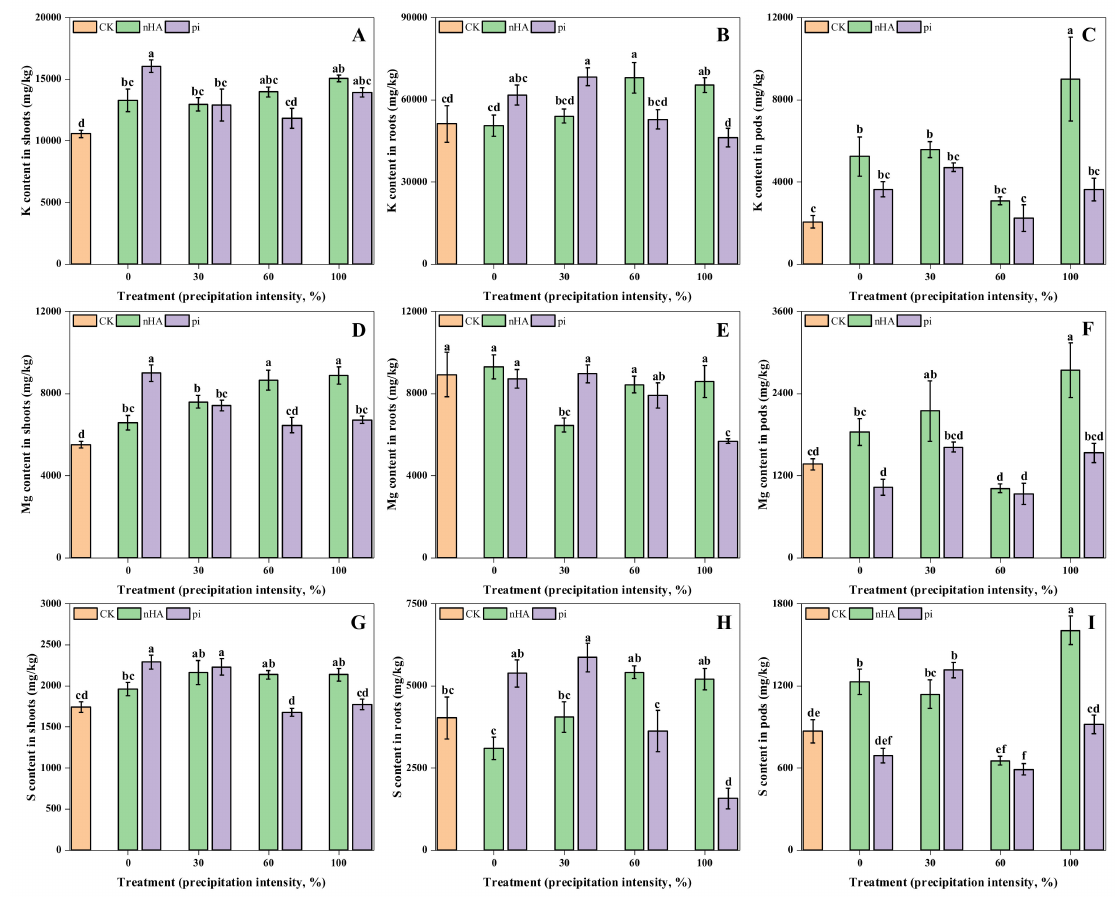
Figure 5. The content of K, Mg, and S in soybean shoots ( A , D , G , respectively), roots ( B , E , H , respectively), and pods ( C , F , I , respectively) treated with nHA or pi (under the simulated precipitation scenario). Error bars correspond to standard errors of the means. Values of each nutrient content that are followed by different letters are significantly different at p <